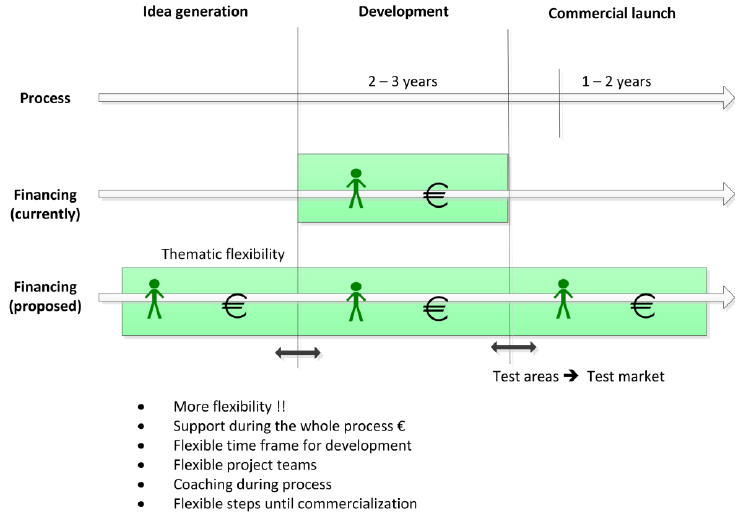
Figure 7. Suggested changes to grant process from workshop 1. Technologies 2018 , 6 , 2